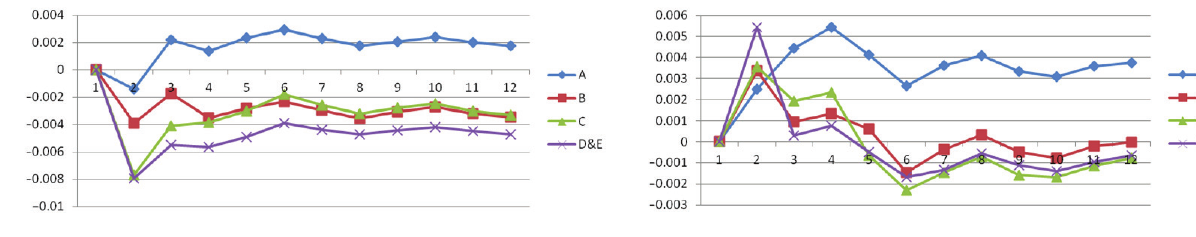
Figure 9c. Accumulated impulse response of PRI to shocks in stock market risk